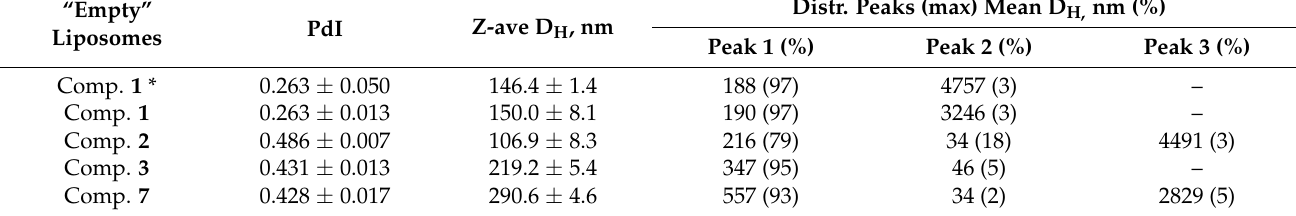
Table 4 . DLS data of "empty" liposome dispersions of 1,4-DHP amphiphiles 1 – 3 and 7 obtained by Table 4. DLS data of “empty” liposome dispersions of 1,4-DHP amphiphiles 1 – 3 and 7 obtained by the REV method without the REV method without ferrofluid (FF) additive. PdI is the polydispersity index; Z-ave D H is the ferrofluid (FF) additive. PdI is the polydispersity index; Z-ave D H is the diameter that represents the mean hydrodynamic diameter that represents the mean hydrodynamic diameter of all liposomes in the distribution. diameter of all liposomes in the distribution. The mean hydrodynamic diameter, D H , depicts the hydrodynamic size of the The mean hydrodynamic diameter, D H , depicts the hydrodynamic size of the main population of main population of the tested sample. the tested sample.